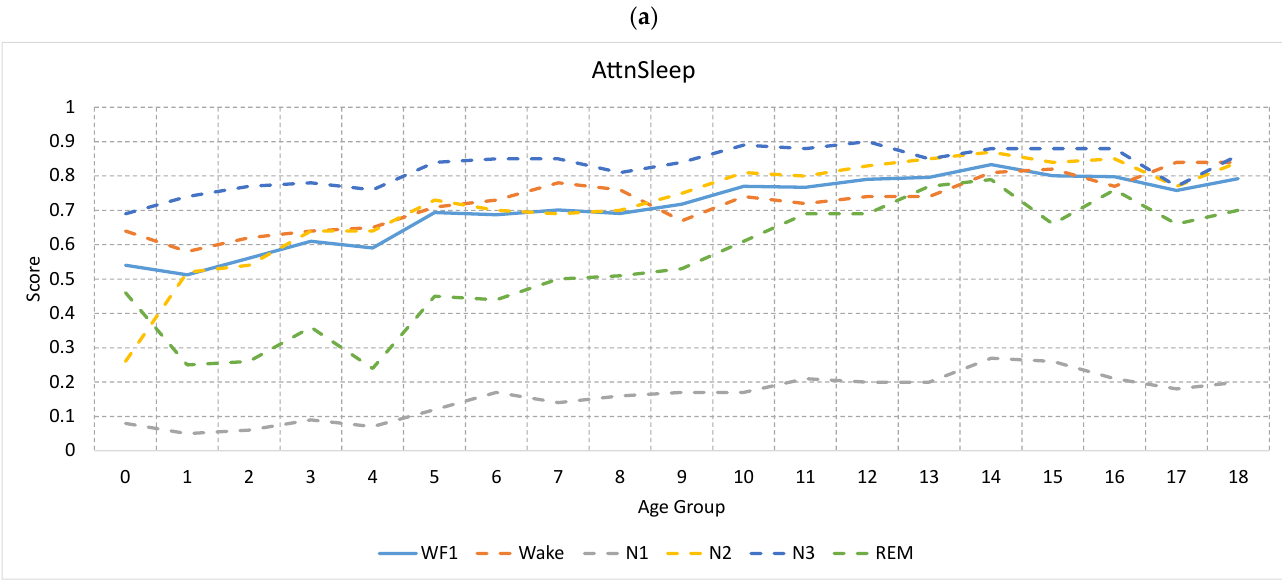
Figure 9. The breakdown of the adult model performance over different sleep stages for ( a ) DeepSleepNet and ( b ) AttnSleep.